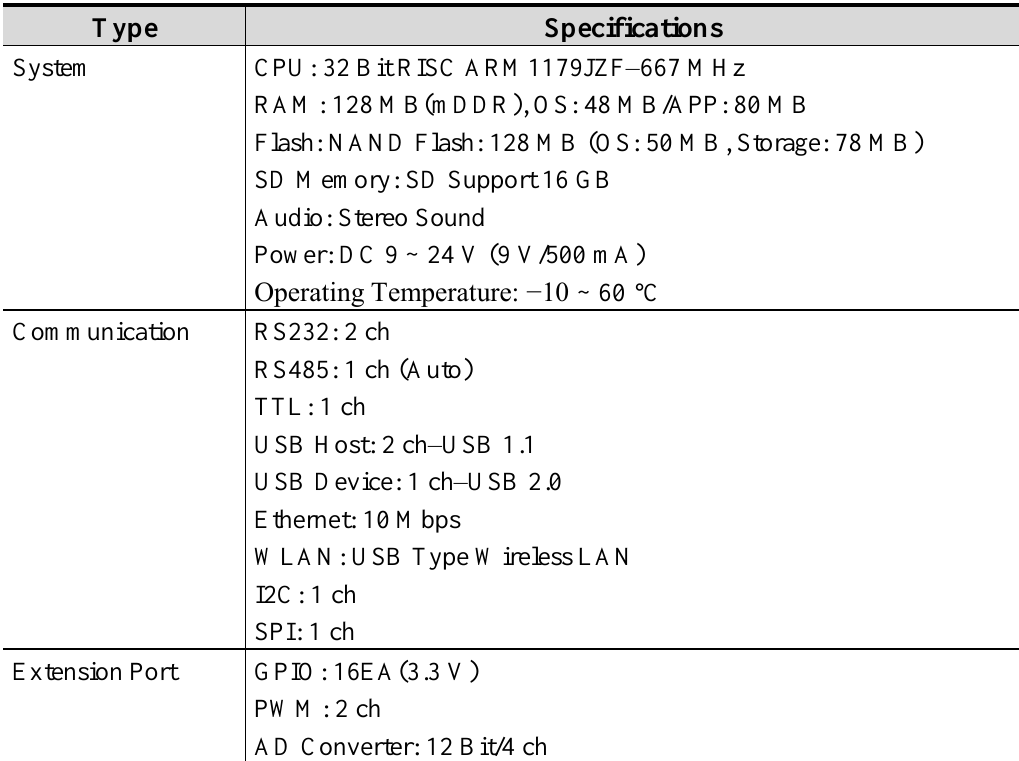
Table 4. Hardware Specifications of the Embedded Board